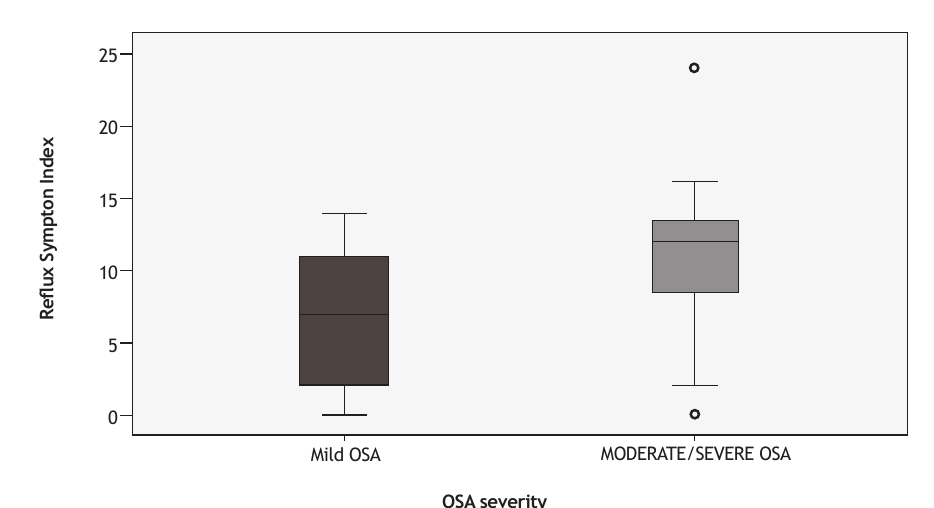
Figure 1 Box-plot between Reflux Symptom Index (RSI) and Apnea-hyponea Index (AHI) in obese patients. Mild obstructive sleep apnea (OSA), AHI < 15 events/hour; moderate/severe OSA, AHI ≥ 15 events/hour.